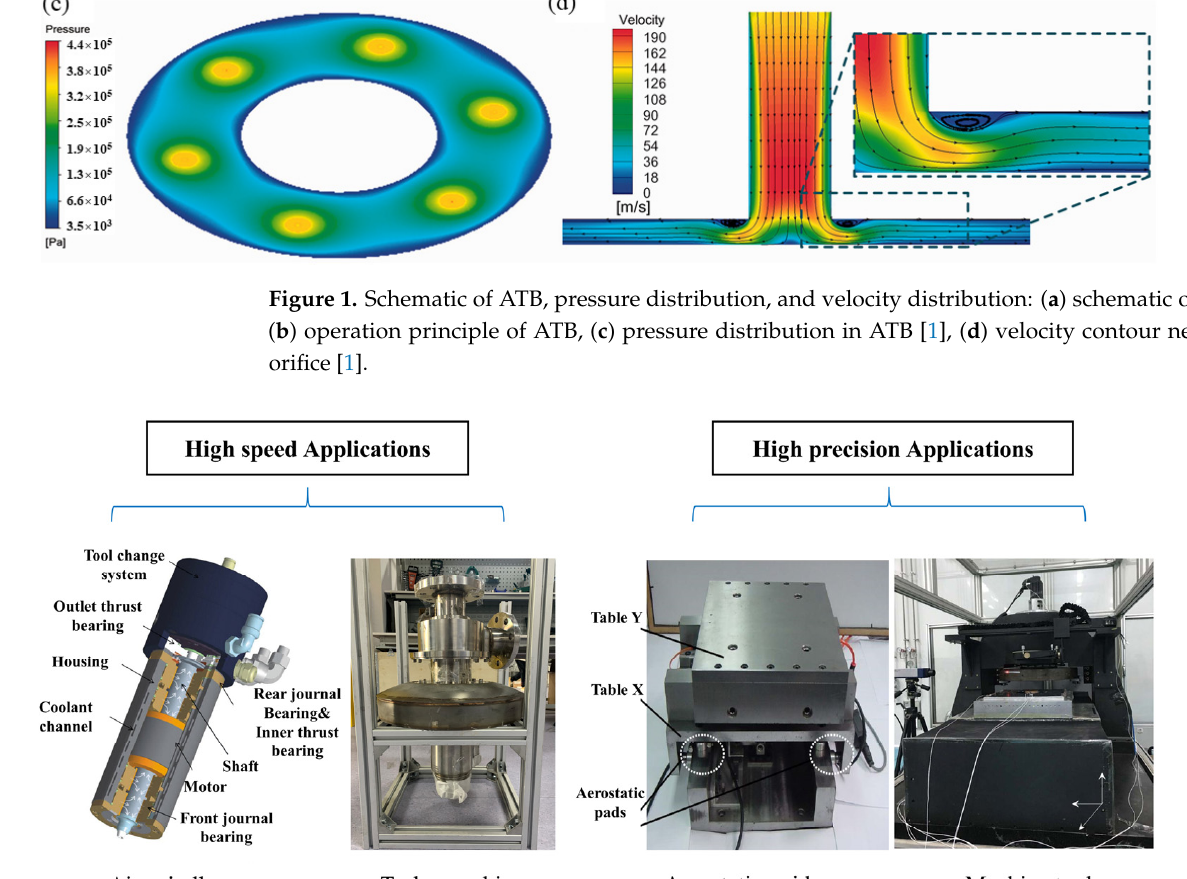
Figure 1. Schematic of ATB, pressure distribution, and velocity distribution: ( a ) schematic of ATB, ( b ) operation principle of ATB, ( c ) pressure distribution in ATB [1], ( d ) velocity contour near the orifice [1].